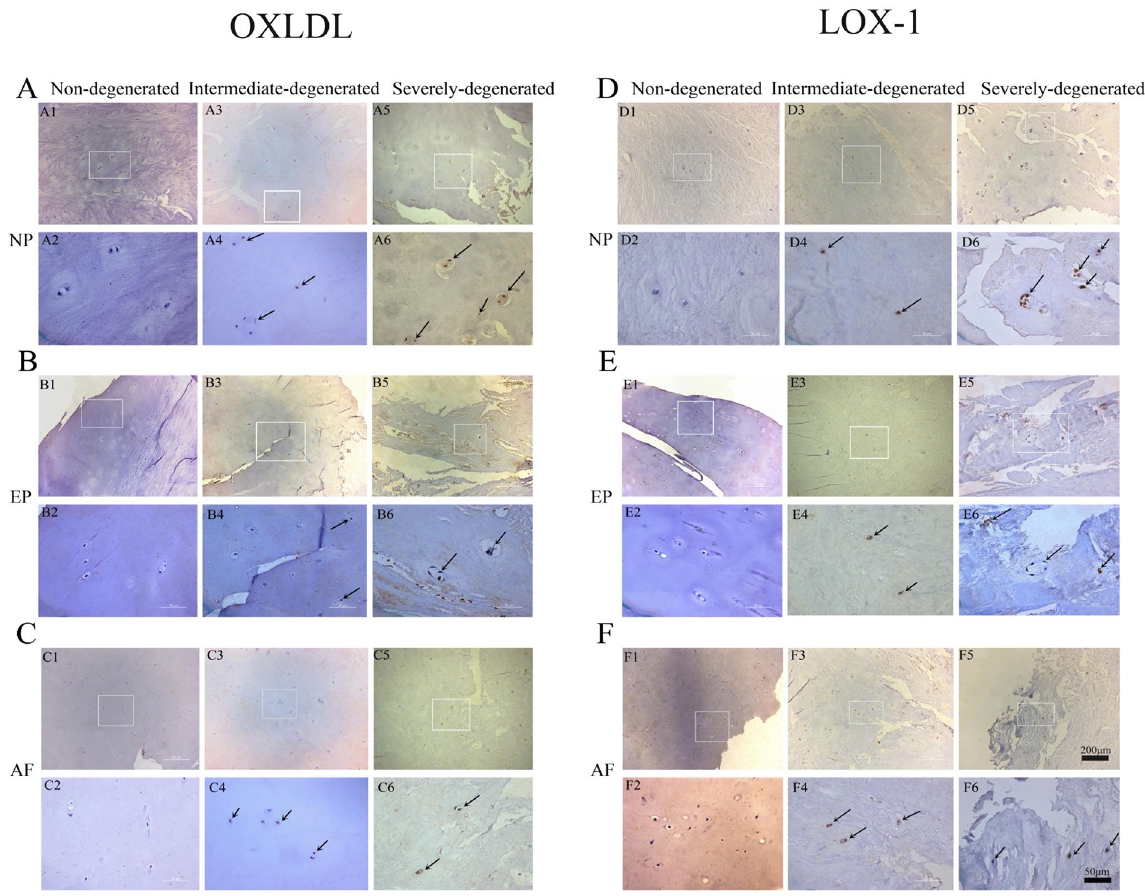
Figure 1. Examples of immunohistochemical staining for LOX-1 (1:100, Abcam, USA) and oxLDL (1:100, biorbyt, USA) in human intervertebral disc. LOX-1 (row A , B , C ) and oxLDL (row D , E , F ) in non-degenerate discs (A1,A2,B1,B2,C1,C2,D1,D2,E1,E2,F1,F2); intermediate degenerated disc: (A3,A4,B3,B4,C3,C4,D3,D4,E3, E4,F3,F4); Severe degenerated disc: (A5,A6,B5,B6,C5,C6,D5,D6,E5,E6,F5,F6). Immunopositivity is revealed by brown staining. In non-degenerate discs, no cell clusters were seen and little immunopositivity was observed in the single cells. In degenerated discs, a large number of cell clusters were observed, which were predominately immunopositive. Bars = 200 μ m (row 1,3,5), Bars = 50 μ m (row 2,4,6). A one-way ANOVA were used for statistical assessments. ( * P < 0.05, ** P <